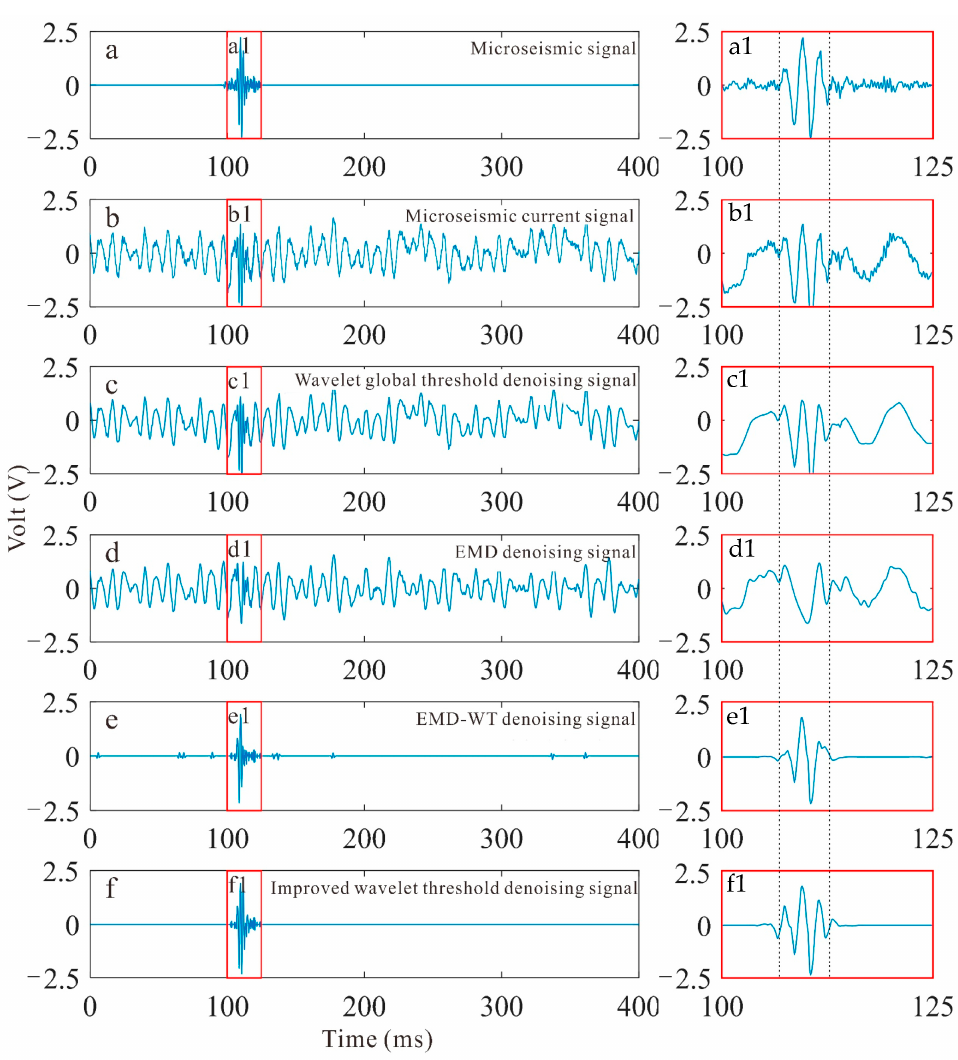
Figure 6. Comparison of the denoising results of t different methods for microseismic current synthesis signals: ( a , a1 ) microseismic signal, ( b , b1 ) microseismic current signal, ( c , c1 ) Wavelet global threshold denoising signal, ( d , d1 ) EMD denoising signal, ( e , e1 ) EMD-WT denoising signal, ( f , f1 ) improved wavelet threshold denoising signal.